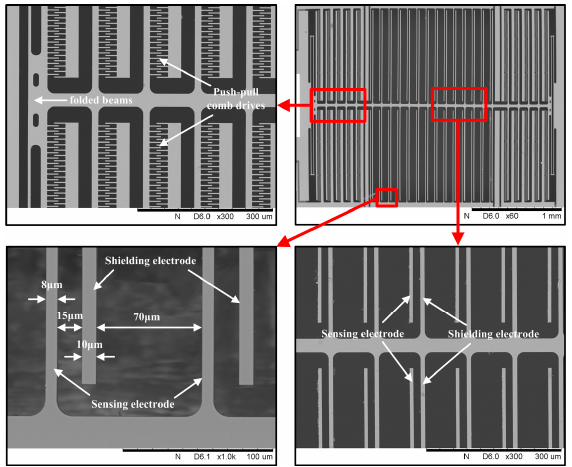
Figure 5. SEM photos of the 1D EFSC. The widths of the sensing and shielding electrodes are 8 µm and 10 µm, respectively; the gaps between sensing electrode and adjacent two shielding electrodes are 15 µm and 70 µm, respectively.